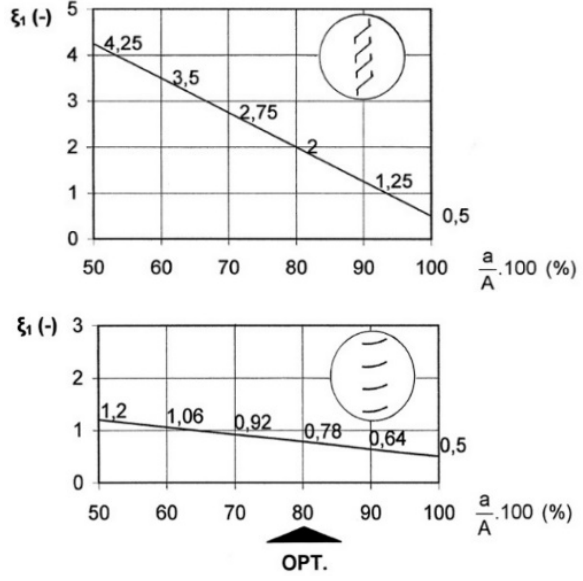
Figure 6: The local aerodynamic drag of the air flow at the inlet part. Upper picture illustrates the conventional rain screen louvers. Lower picture shows aerodynamic louvers (a – net opening area for air flow, A – total area of the inlet air, including the louvers).